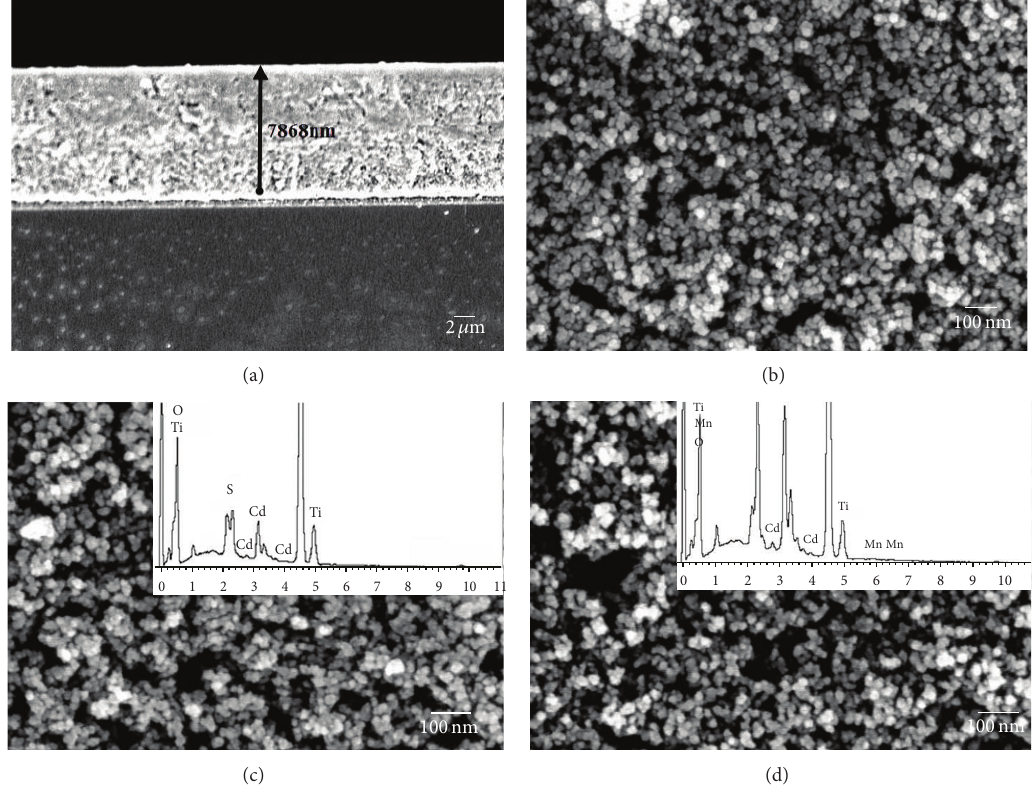
Figure 1: SEM images of (a) cross section of Mn-doped-CdS deposition of TiO 2 photoanode; (b) pure TiO 2 mesoporous film surface; (c) the surface of TiO 2 mesoporous film sensitized by CdS quantum dots; and (d) the surface of TiO 2 mesoporous film sensitized by Mn-doped-CdS quantum dots. Among them, the inset in the following two graphs is the corresponding EDS